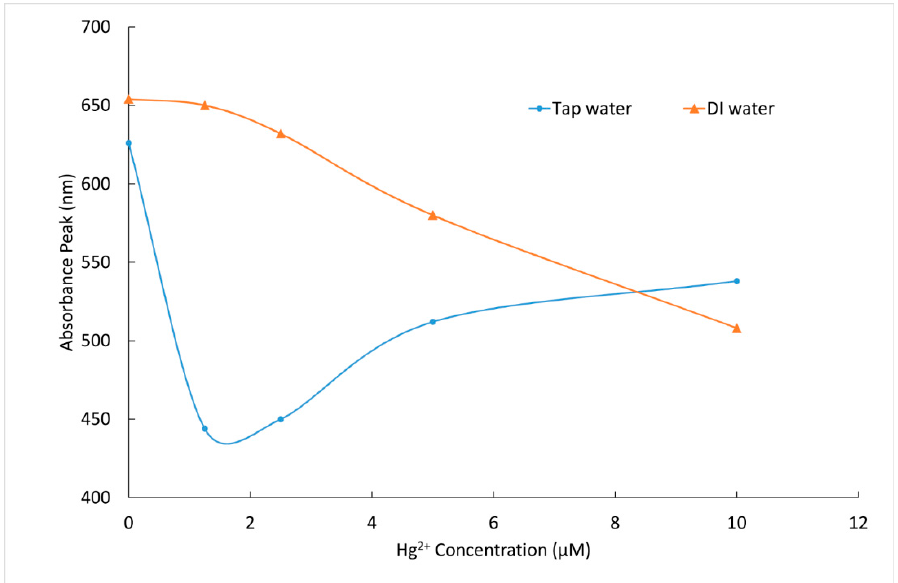
Figure 10. Silver nanoprism solution absorbance peak as a function of Hg 2+ concentration in deionized (DI) water (upper curve) and municipal tap water (lower curve), showing non-linear blue-shift in the tap water matrix.